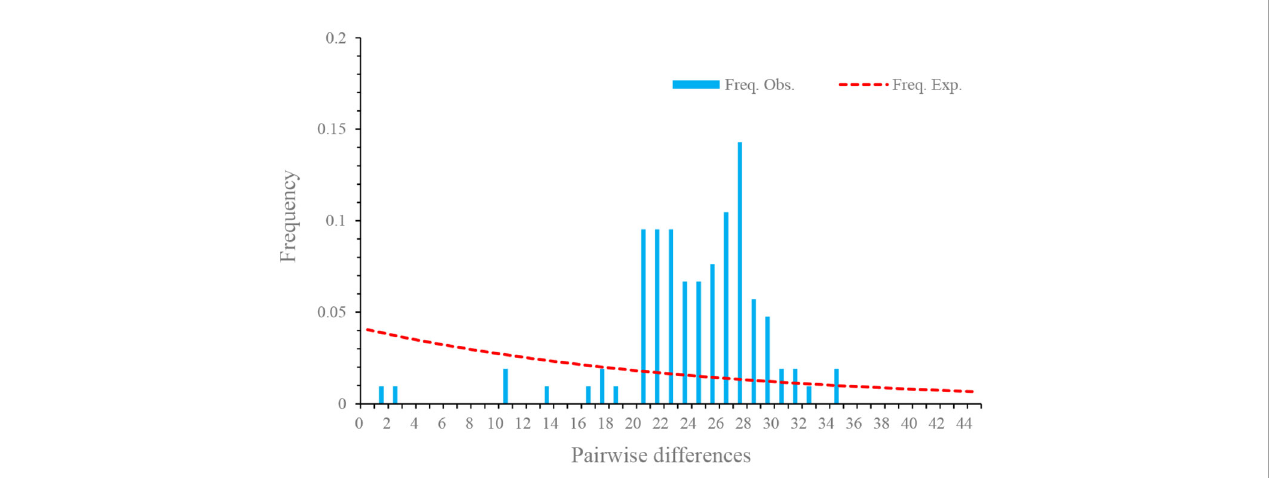
FIGURE 7 Mismatch distributions of Neo fl abelliforma dubium n. sp. population based on the Rpb1 gene.